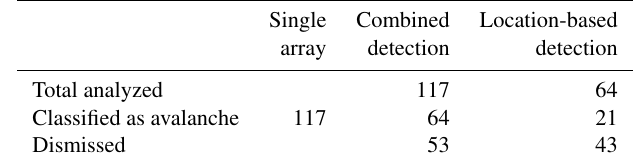
Figure 8. Classification results after post-processing (including voting-based classification) at the Dischma array. The colored bars indicate the number of classified events per day depending on the number of sensors: the violet bar indicates detection by seven sen- sors, turquoise bars indicate detection by six sensors and yellow bars indicate detection by five sensors.